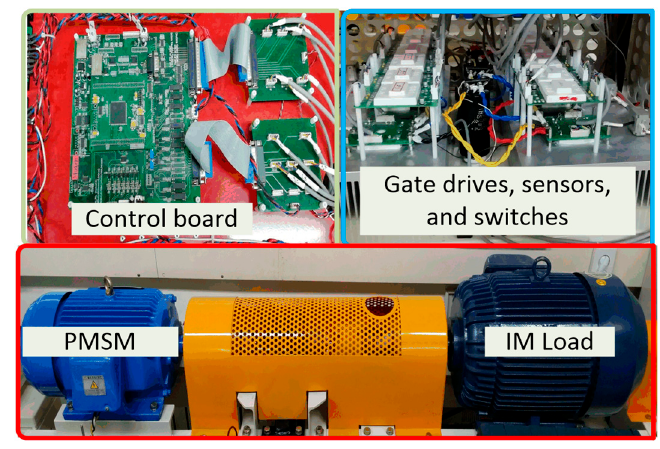
Figure 8. Experimental setup.